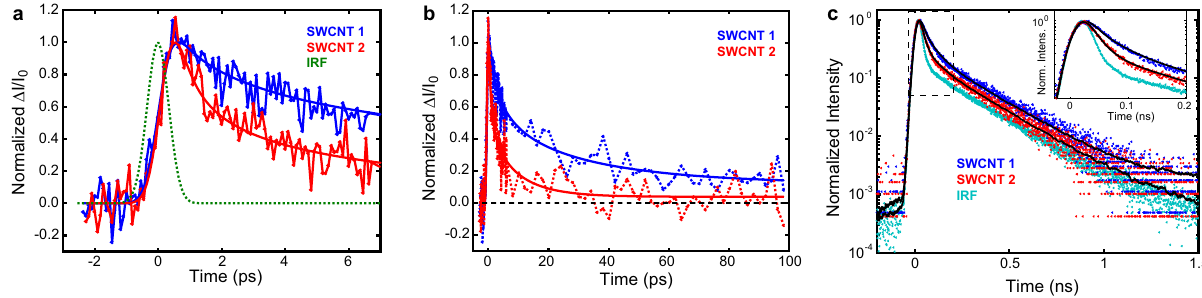
Fig. 2 | Exciton dynamics in single SWCNTs. Pump-probe transients detected for two different (6,5) SWCNTs in a short ( a ) and a long ( b ) time range, respectively,